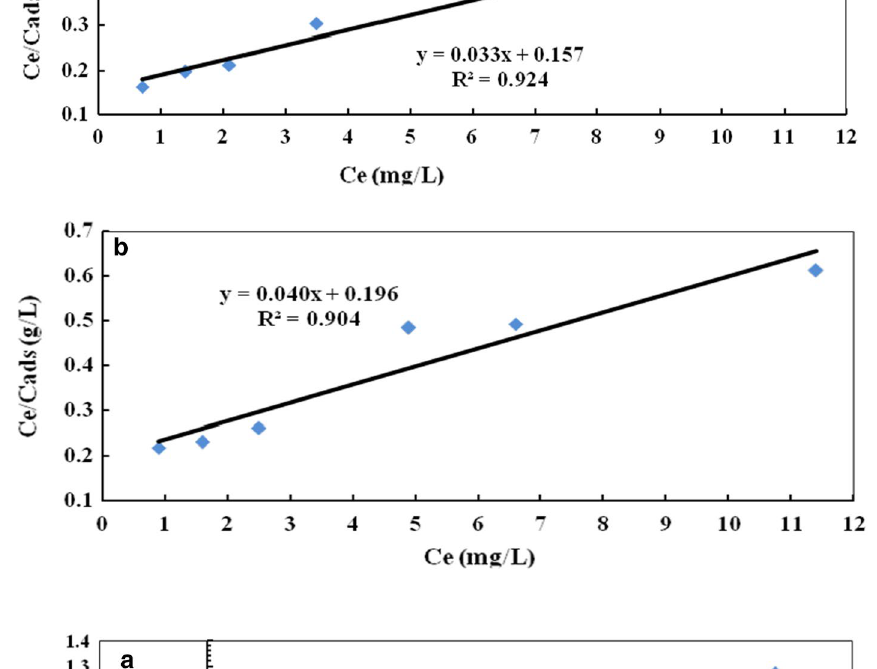
Fig. 10 a , b Freundlich model for chromium ions removal using a ACP-Zn and b ACP- Zn-Fe at pH 2.0—2.5 and 25 ± 0.2 °